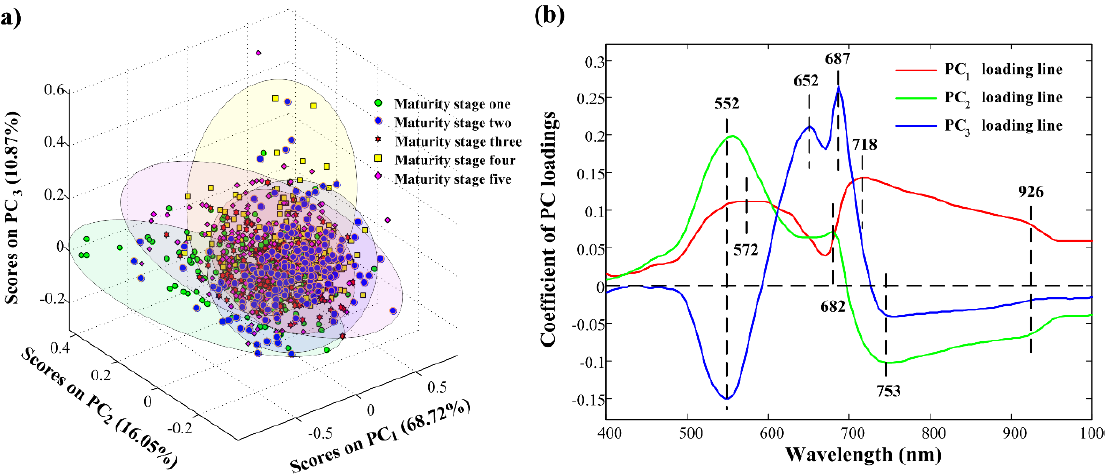
Figure 5. PCA results. ( a ) Score plot; ( b ) PC loading lines. PCA, principal component analysis; PC, principal component. principal